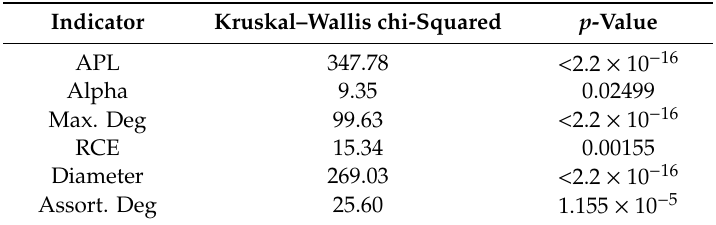
Figure 12. Distribution of MST topological indicators in different market states. Source: Own study. Table 1. Kruskal–Wallis rank sum test